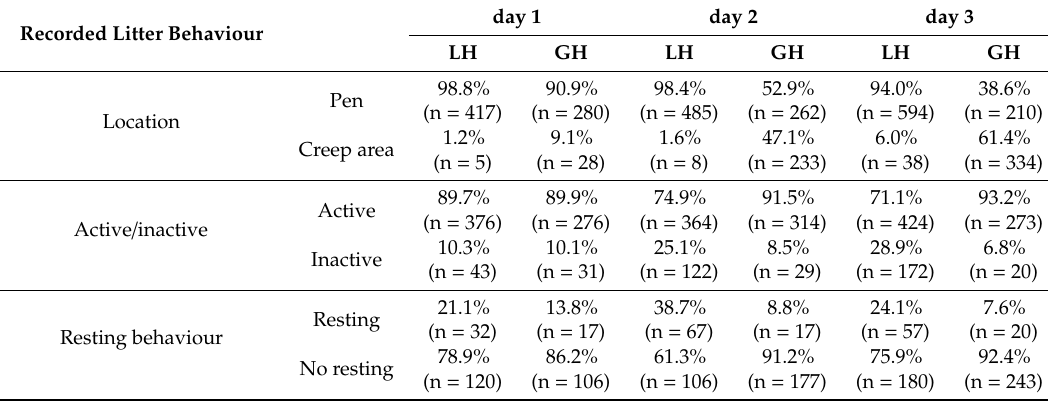
Table 6. Percentages of recorded litter behaviour (location, active / inactive, resting behaviour next to the sow immediately before rolling) on di ff erent examination days. Farrowing systems: FC = pen with farrowing crate; LH = single loose housing pen; GH = single loose housing pen of the group housing